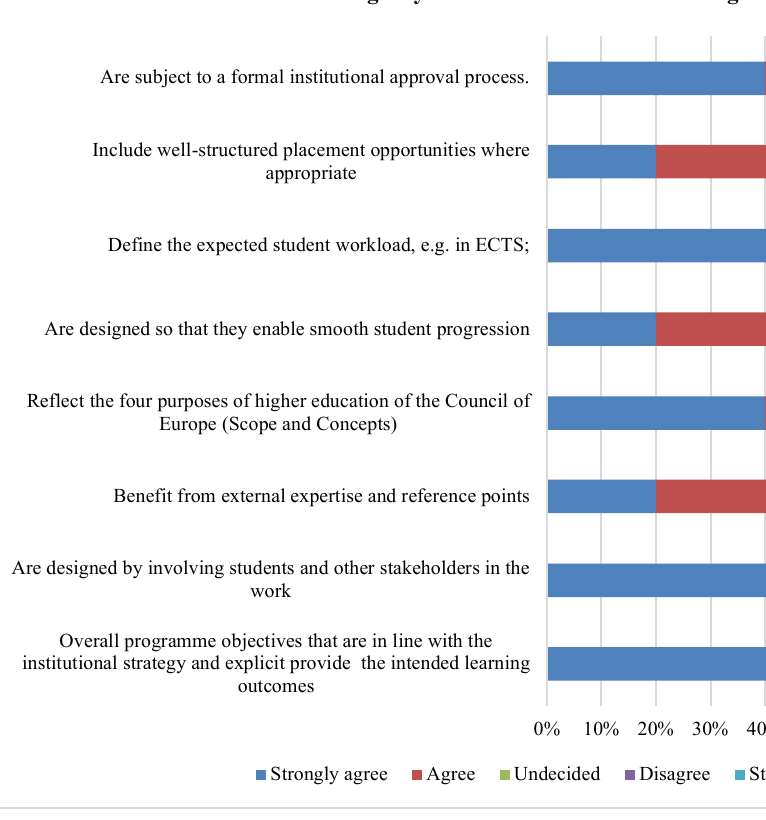
Figure 4 : Design and approval of programs in Albanian